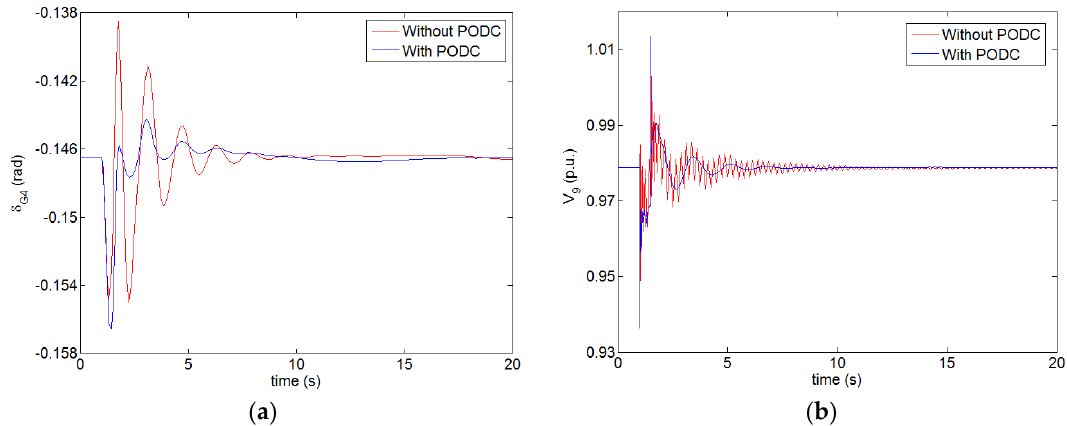
Figure 6. Response curves without and with the PODC: ( a ) the angle curves of G 4 , and ( b ) the voltage curve on bus 9.